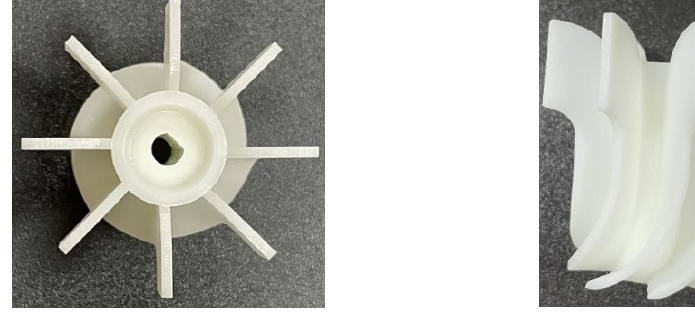
Figure 9. Optimal impeller scheme obtained by range analysis. Table 5. Comparison of the original and optimization schemes.